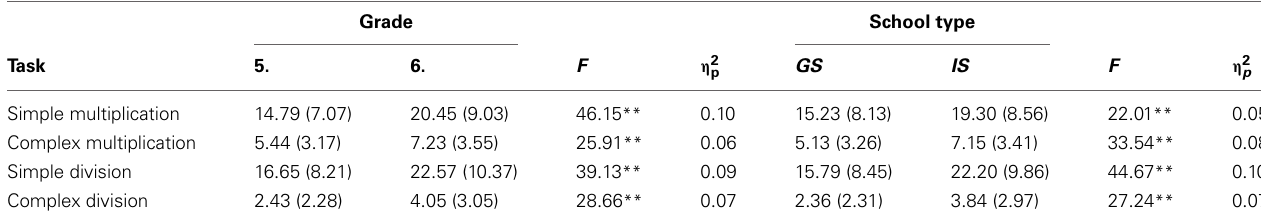
Table 1 | Means (SD in parenthesis) and F -values for general (GS) and intermediate (IS) secondary schools and fifth and sixth